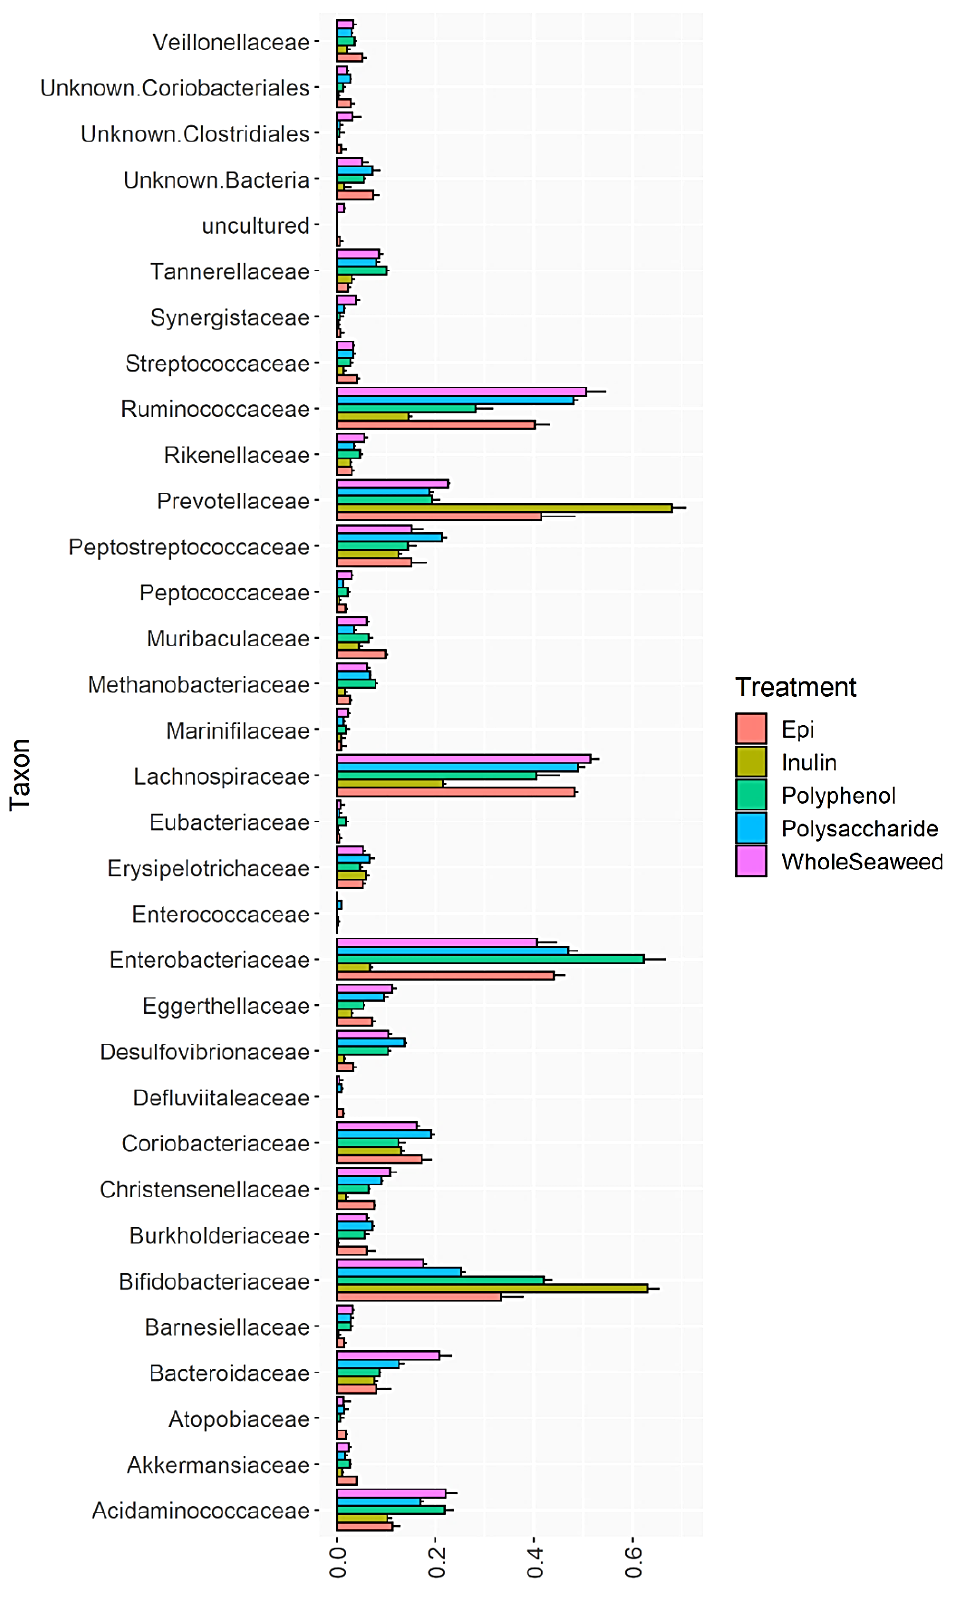
Figure 1. Relative abundance of bacterial families after 24 h fermentation with P. comosa WH, PS, PP, INU or EGCG.